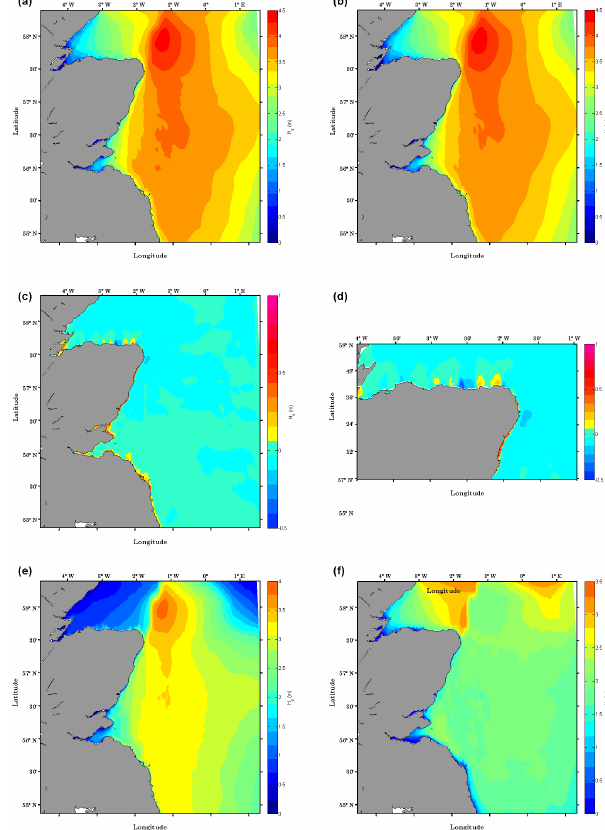
Figure 9. The modelled H s on the east coast of Scotland at 12:30UTC on 26 February 2010: (a) coupled model (mean WCI included), (b) uncoupled model (mean WCI not included), (c) dif- ference between coupled and uncoupled models, (d) difference be- tween coupled and uncoupled models in the Moray Firth area, (e) windsea waves, (f) swell